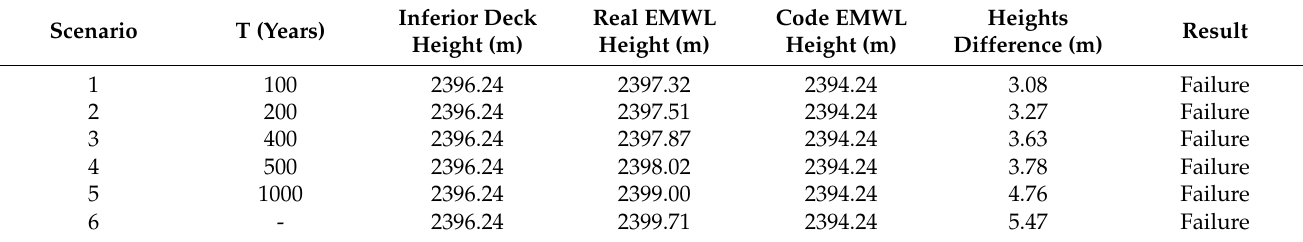
Table 4. Results of the Extraordinary Maximum Water Level analysis.